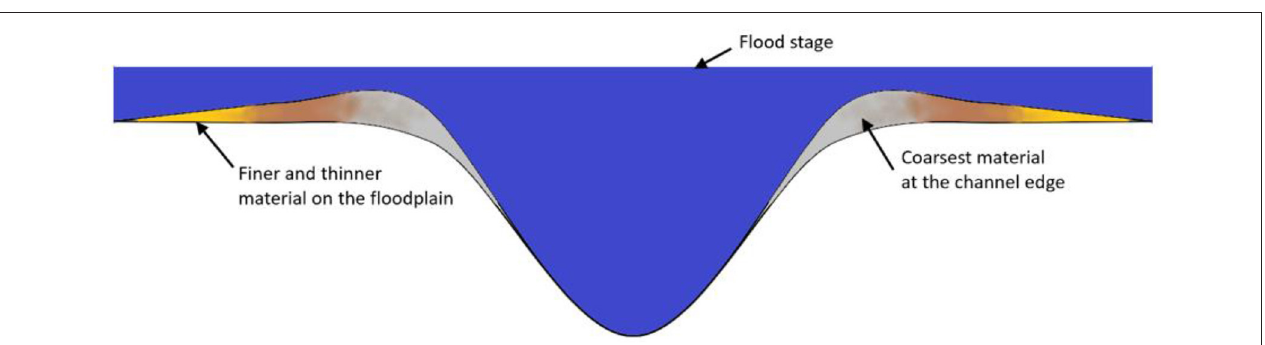
FIGURE 10 | Cross sectional sediment deposition (created from information in Brierley et al., 1997).